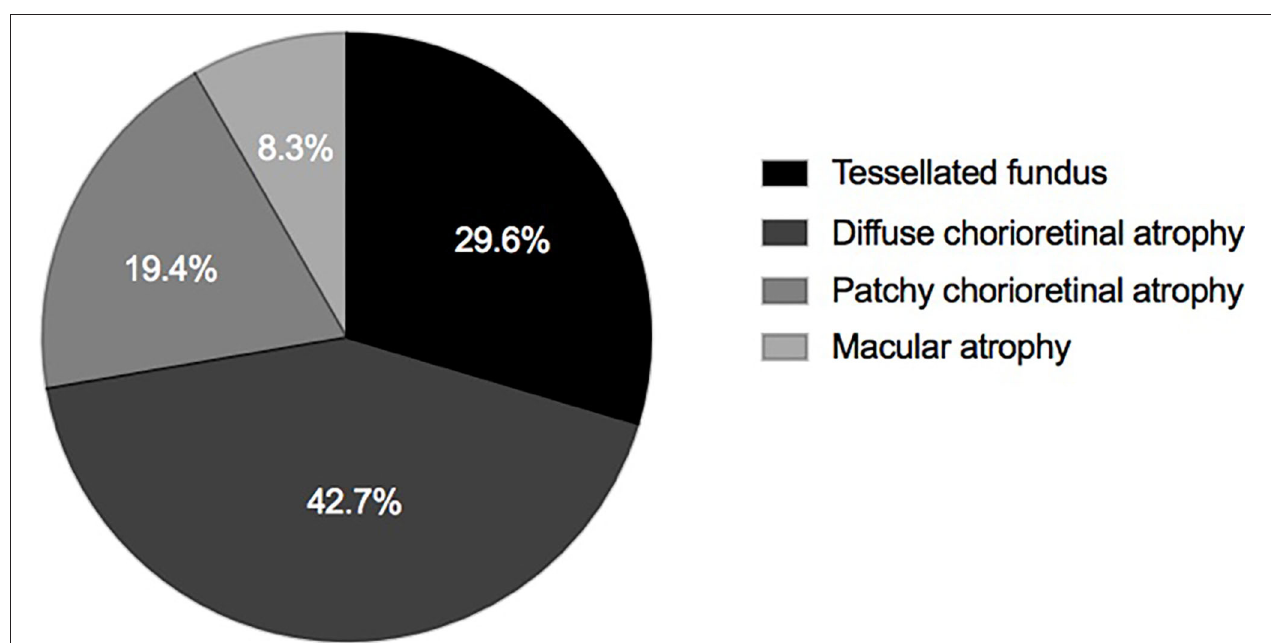
FIGURE 1 | Distributions of myopic atrophy maculopathy in eyes with definite myopic tractional maculopathy.